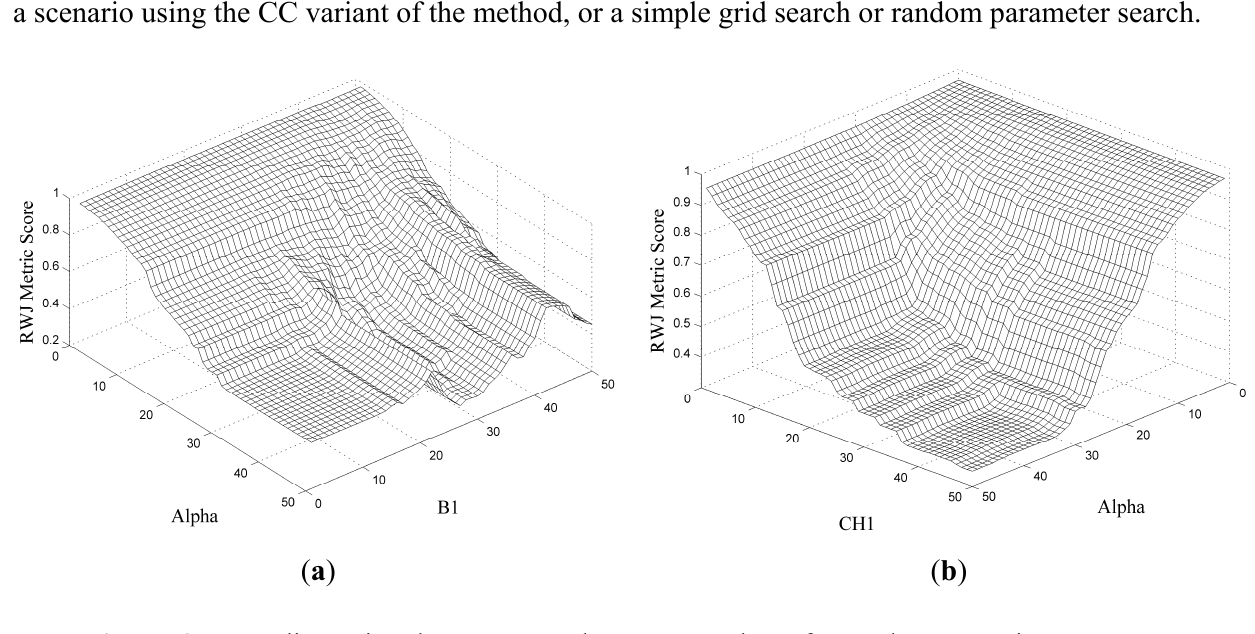
Figure 8. Two-dimensional parameter plots, or search surfaces, demonstrating parameter interactions between method constituents: ( a ) illustrates the interaction of the alpha parameter from the CC constituent and that of a mapping function parameter, while ( b ) shows the interaction of alpha with the CH1